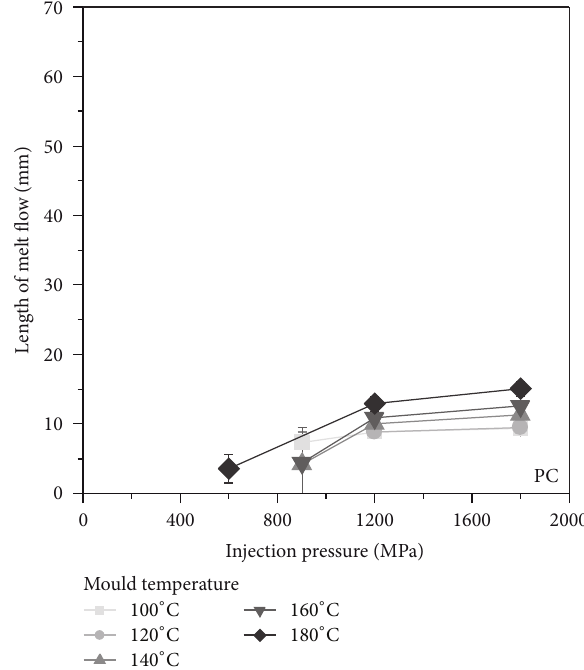
Figure 7: Flow length as function of injection pressure and mould temperature for